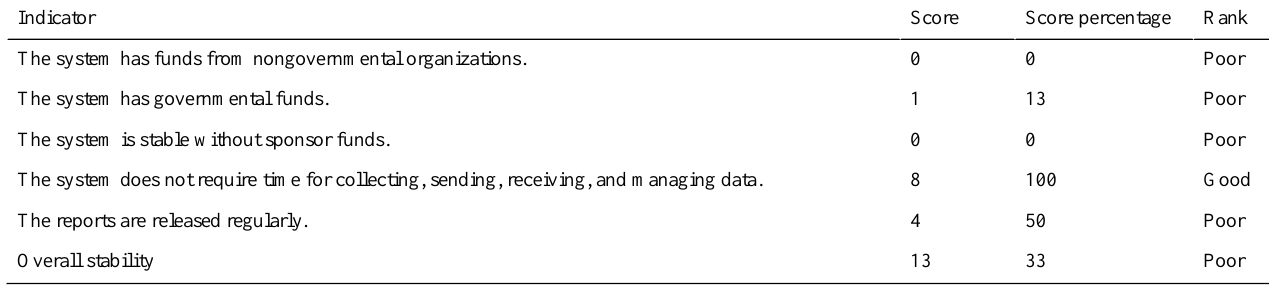
Table 3. The score, score percentage, and rank of stability indicators of the Neonatal Tetanus Surveillance System in Sana’a, 2018 (n=8).